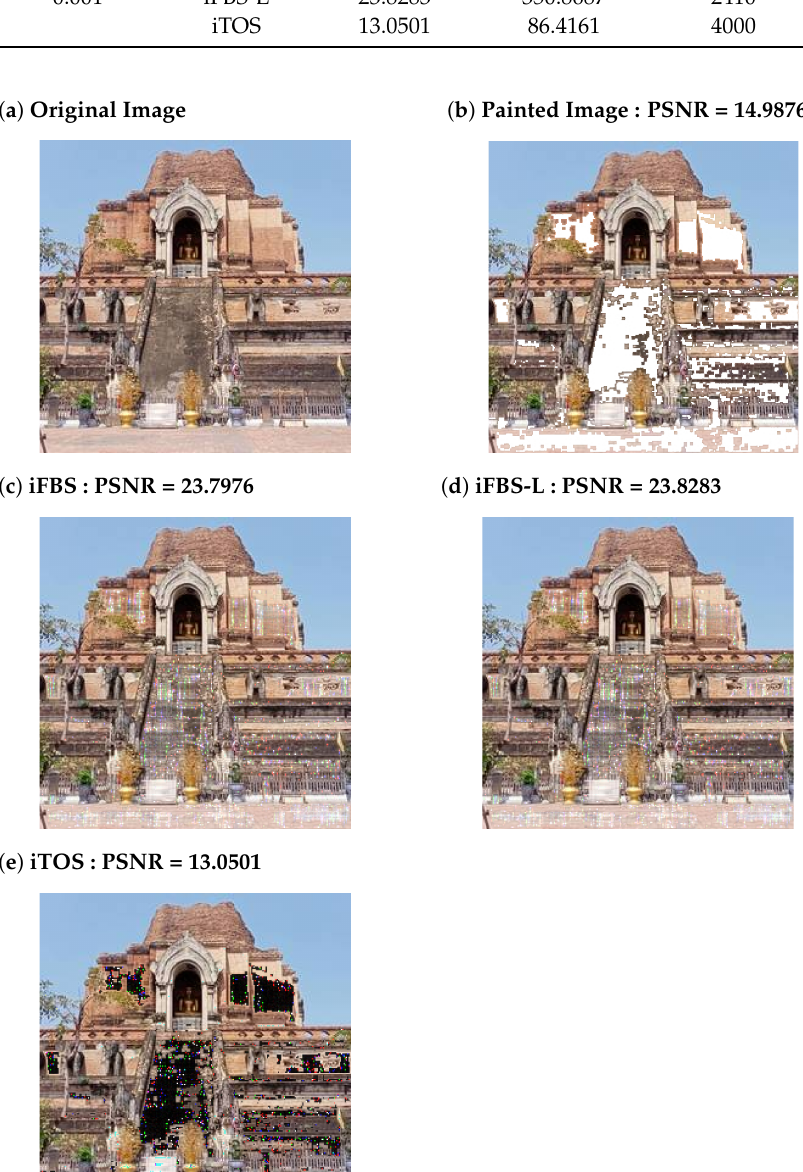
Figure 1. The original image, painted image, and restored images in the case of a regularization parameter of τ =